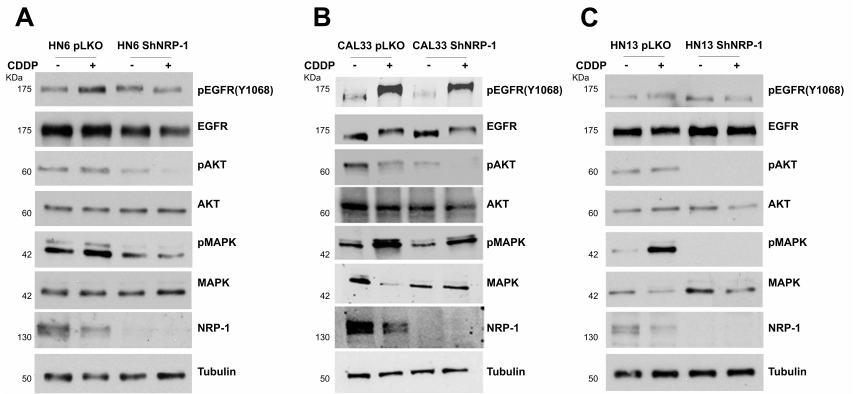
Figure 4. NRP-1 sustains CDDP-induced EGFR activation. Western blot detection of pEGFR (Y1068), and EGFR in HN6 ( A ), CAL33 ( B ), and HN13 ( C ) cells silenced for Neuropilin-1 (shNRP-1) or control (pLKO) following treatment with cisplatinum for 6 h.